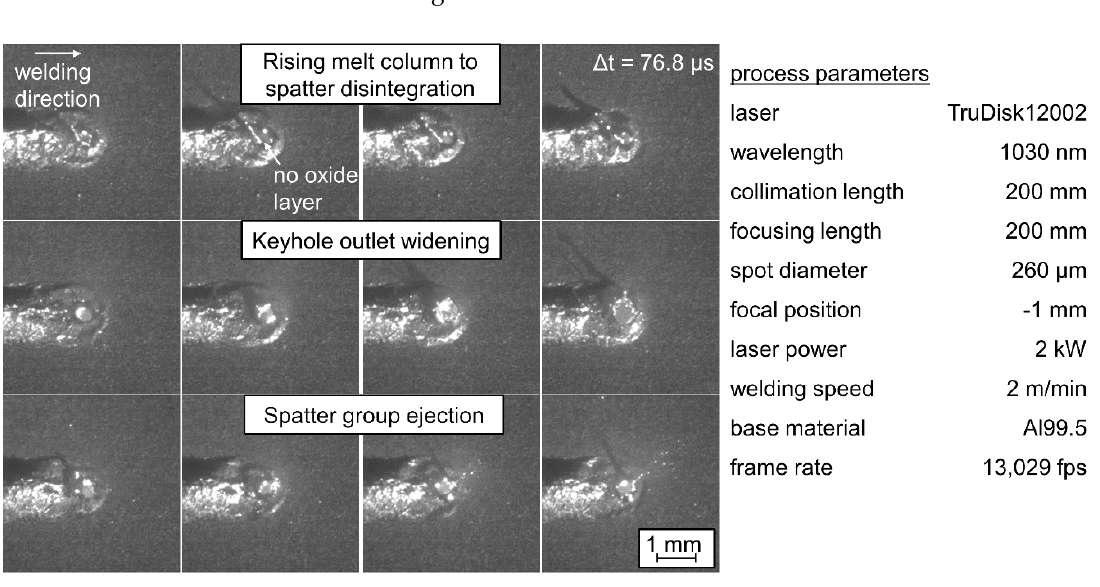
Figure 6. Frame series in the above view on the spatter behavior effects for Al99.5.